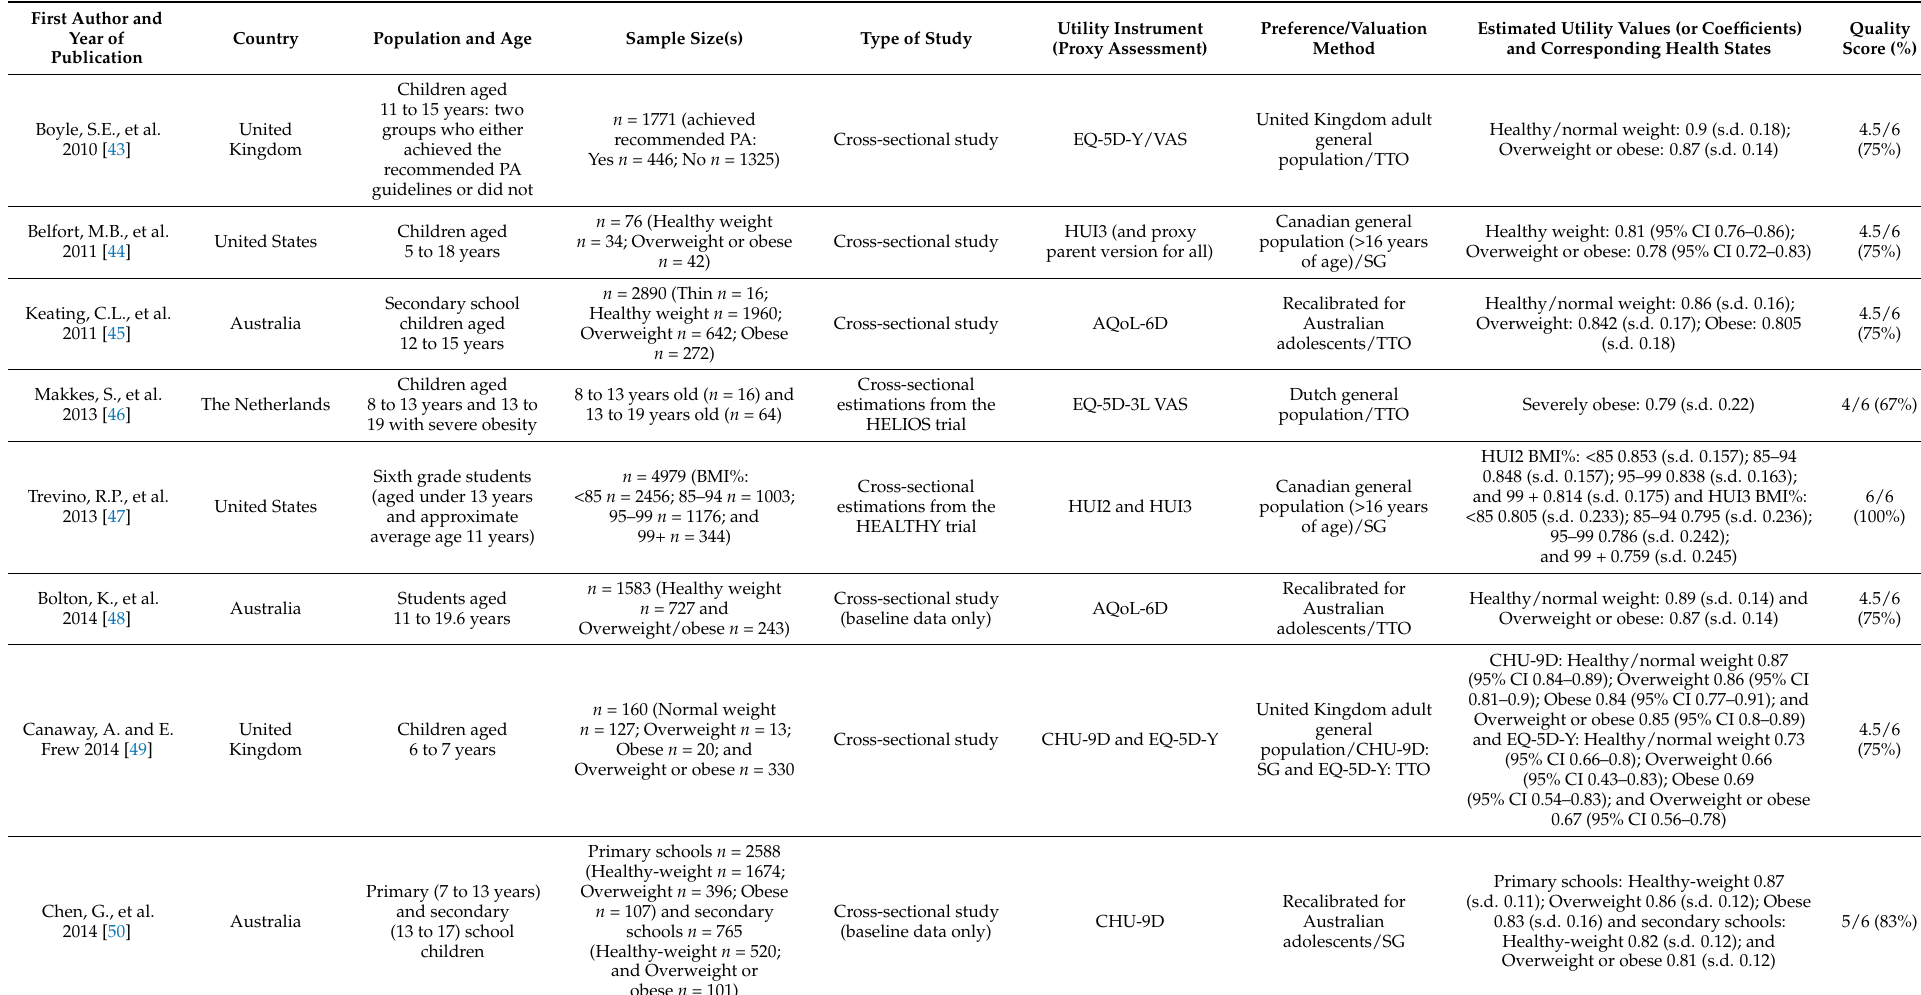
Table 3. Descriptive analysis of the key items on health utility values associated with childhood excess